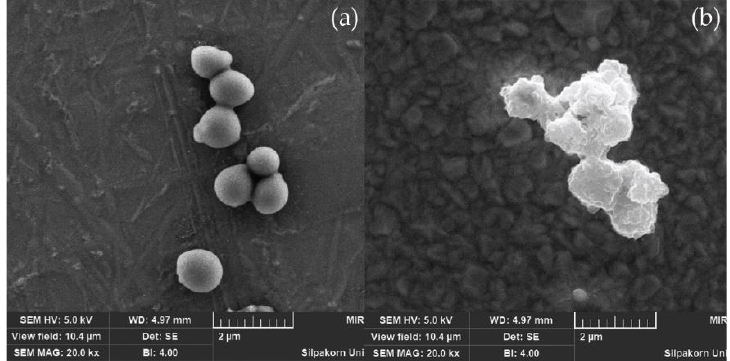
Figure 2. SEM micrographs of ( a ) LNR and ( b ) LNR−g−MMA (magnification ×20,000).